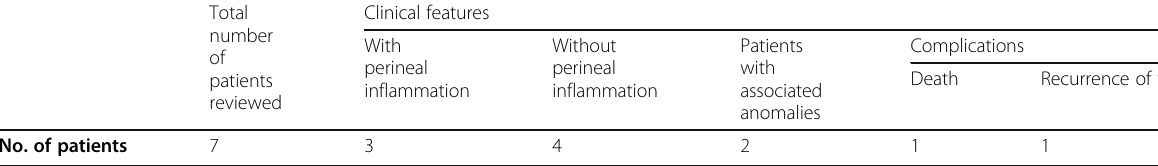
Table 2 Clinical features of reviewed cases of female anorectal